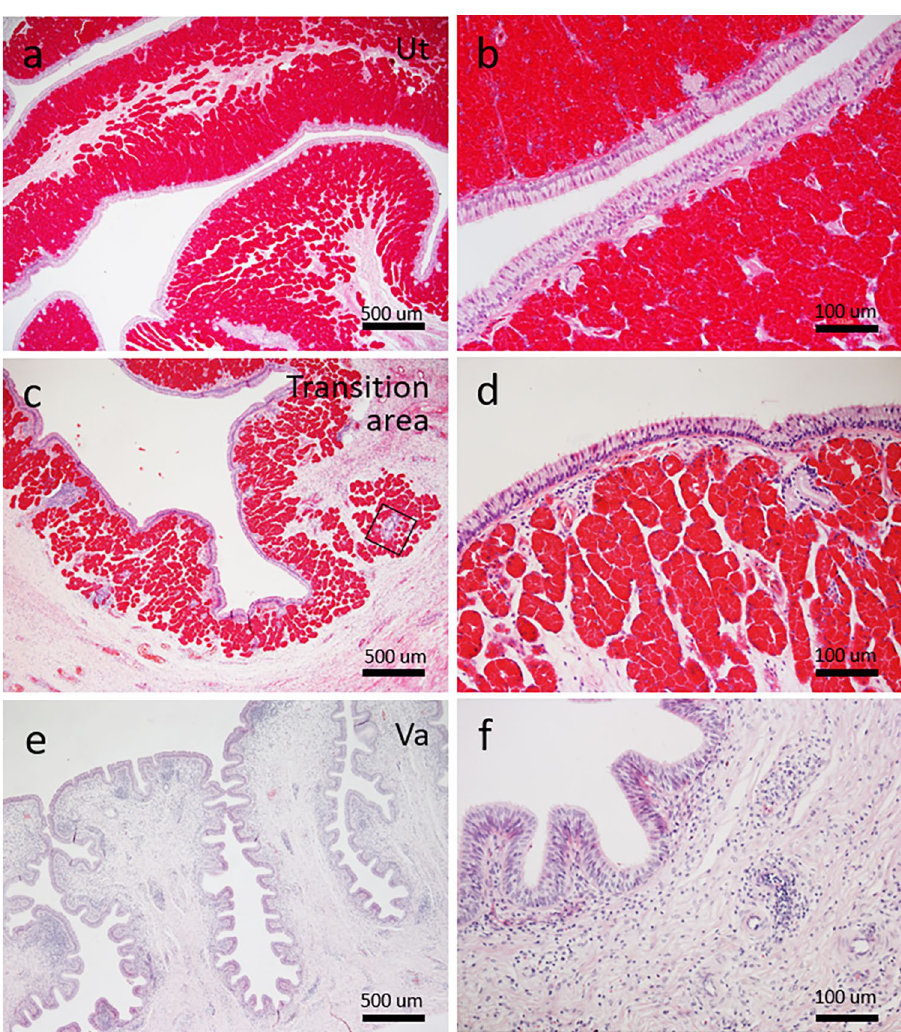
Figure 3. Histological features of oviduct from uterus to vagina in green turtle (ID-035). ( a,b ) Uterus (Ut). Lamina propria contains more eosinophilic glands than proximal portion of isthmus (also see also Fig. 2). ( c,d ) Transition area between uterus and vagina. Eosinophilic glands are sparser than those in uterus. Box ( c ) corresponds to Fig. 4c. ( e,f ) Vagina (Va). Lamina propria does not contain glands. Bars, 500 ( a,c,e ) and 100 ( b,d,f ) μm.